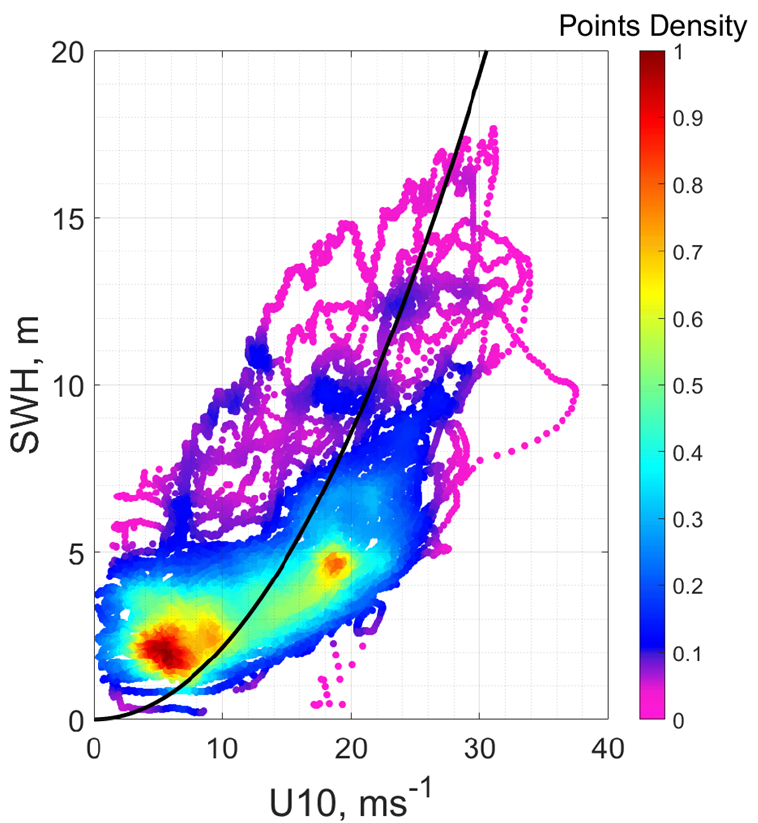
Figure 7. Two − dimensional scatter plot of significant wave height SWH as a function of wind speed, colored with points density. The black curve shows the H s